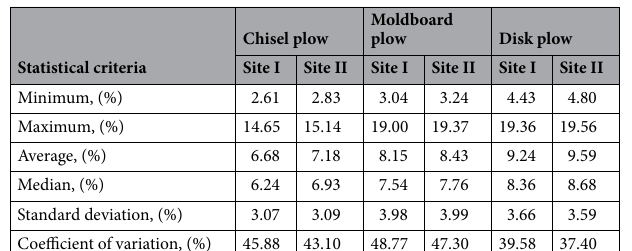
Table 2. Statistical description of the tractor rear wheel slip during tillage process .